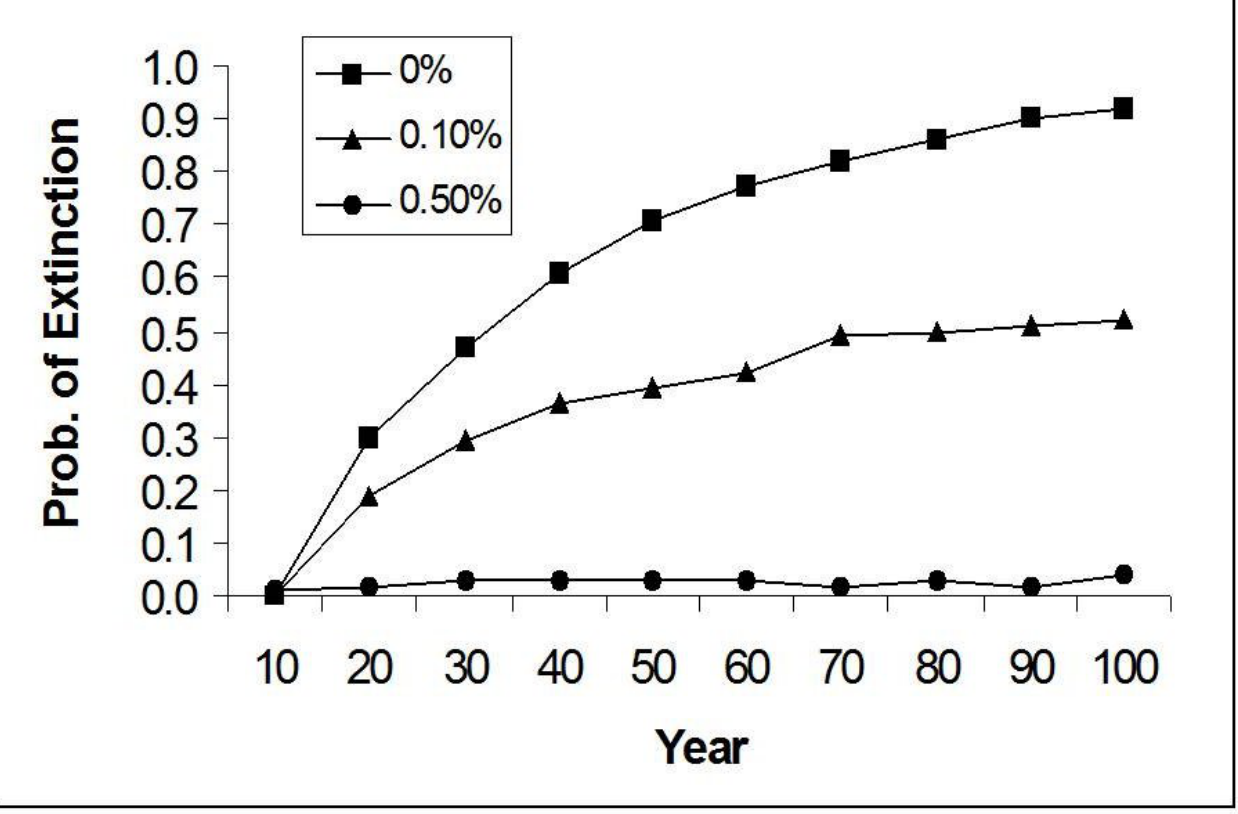
Fig. 4. Probability of extinction within Kuraby Bushland with different values for probability of dispersal from the larger Karawatha Forest remnant (based on 500 iterations). Dispersal has been set at 0, 0.1%, and 0.5% per year. Initial population size in Kuraby was 12, but with carrying capacity set at